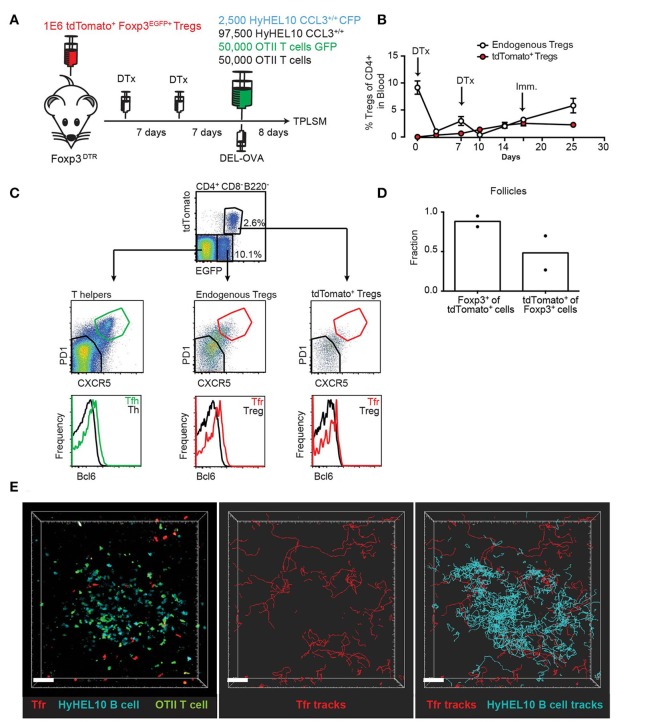
2P visualization of Tfr cells and HyHEL10 GC B cells. (A) Experimental diagram for generation of recipient mice with large numbers of highly fluorescent tdTomato+ Tregs and visualization of Tfr and HyHEL10 (Hy10) GC B cells in the dLNs by 2P microscopy. (B) Flow cytometry analysis of the endogenous and transferred TdTomato+ Treg numbers in the blood of FoxP3DTR mice throughout their treatments with DTx and immunization, performed as in (A). (C–E) Analysis of dLNs from mice generated through the procedure described in (A) at 8 d.p.i. (C) Representative flow cytometry analysis of Bcl6 expression in the CXCR5lowPD1low and CXCR5highPD1high subsets of tdTomato+ Tregs (top panels), endogenous Tregs (middle panels) and endogenous Th cells (bottom panels). (D) Confocal immunofluorescence analysis of dLN sections for the fraction of tdTomato+ cells that express Foxp3 (left bars) and fraction of Foxp3+ cells that express tdTomato+ (right bars) in GC-containing follicles. (E) Representative 2P imaging analysis of Tfr cells localization with respect to GCs. Snapshot (left panel) from an intravital imaging experiment as analyzed in Imaris software. Cell trajectory analysis for Tfr cells (middle panel) and both Tfr cells and GC B cells (right panel). Scale bars 40 μm. Data are from two independent experiments.